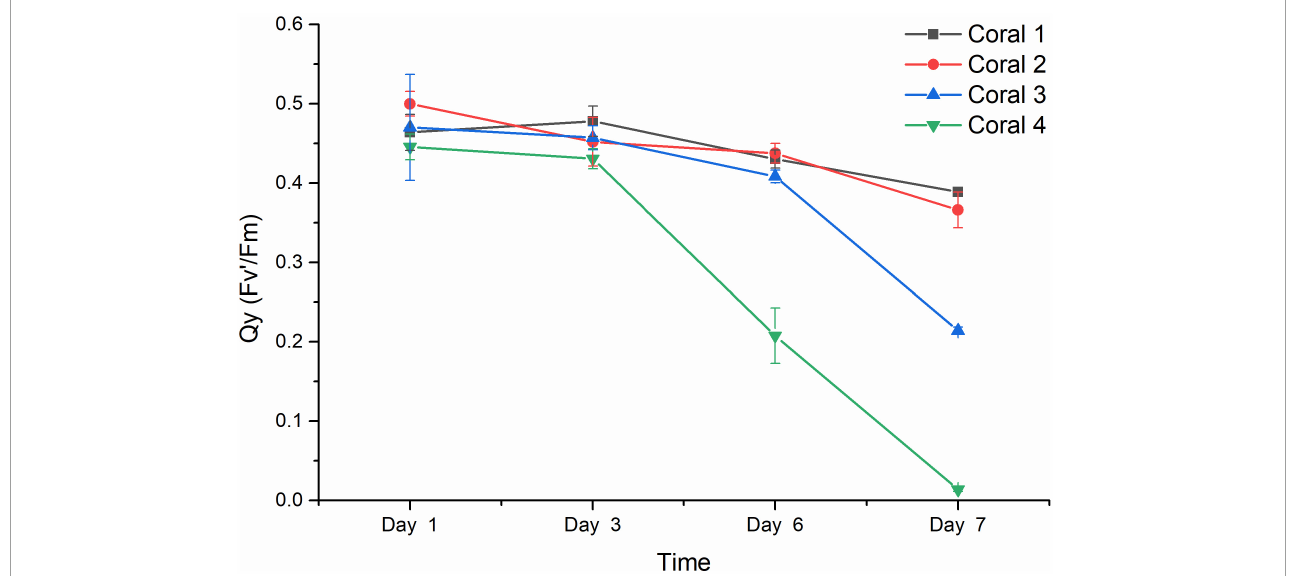
FIGURE3 Chlorophyll fluorescence quantum yield (Fv’/Fm) of coral holobiont. The Qy (Fv’/Fm) was measured using PAM fluorimetry at 3 points of coral middle parts and 3 points of coral tip ends, to obtain the average value and standard deviation of each coral branch. Corals 1 and 2 represented the corals treated with seawater in the blank; corals 3 and 4 represented the corals infected by V. fortis S10-1. The Qy of coral 1 is present by (cid:122) in black line, coral 2 by • in red line, coral 3 by (cid:78) in blue line, and coral 4 by (cid:72) in green line.